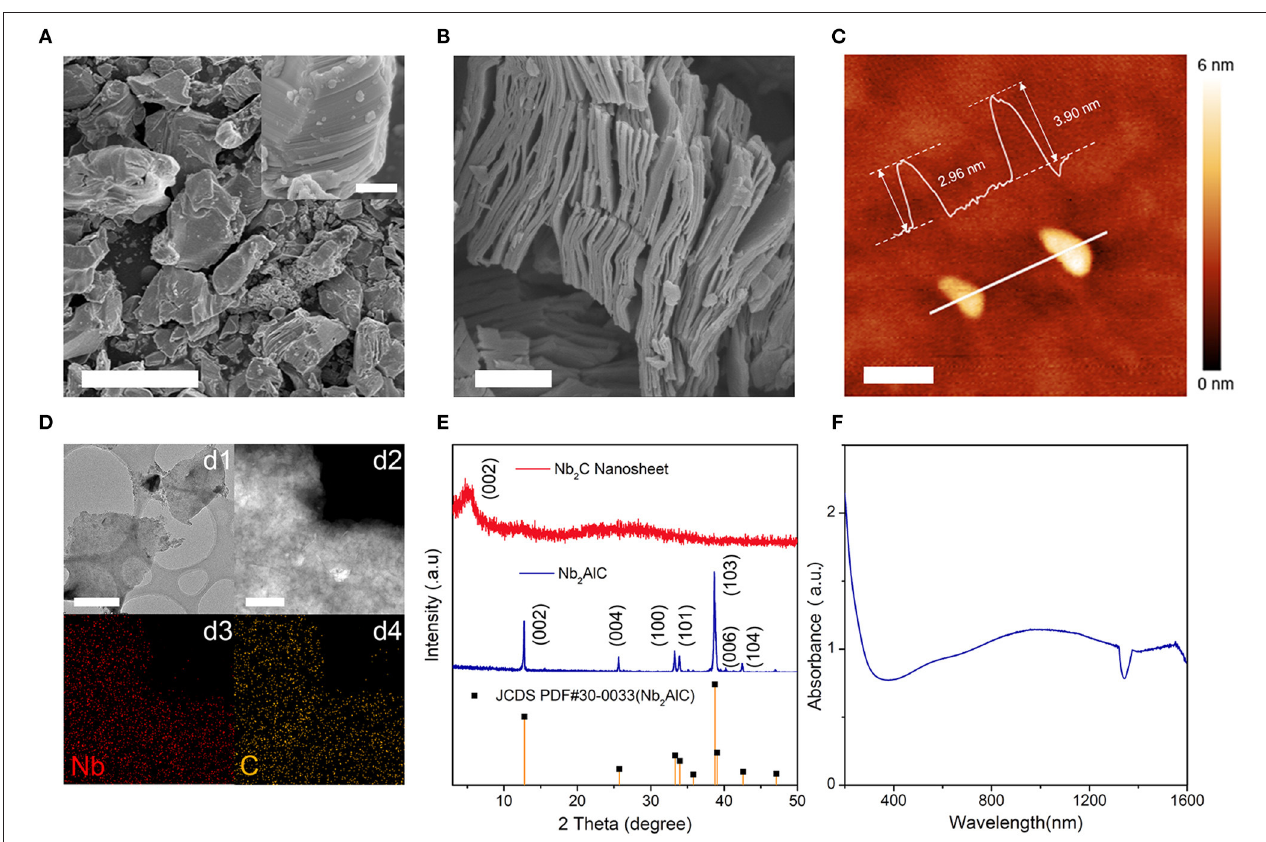
FIGURE 1 | (A) SEM images of Nb 2 AlC powder. Scale bars are 10 and 1 µ m in (A) and inset. (B) SEM image of multilayer Nb 2 C. Scale bar is 1 µ m. (C) AFM image of Nb 2 C. Scale bar is 200nm. ( D ,d1) TEM image, and (d2) HAADF image. (d3,d4) are EDS mapping of few-layer Nb 2 C nanosheets. Scale bars are 1 µ m and 200nm in (d1,d2). (E) XRD patterns of Nb 2 C (upper) and Nb 2 AlC (lower). (F) UV–vis–NIR absorption spectra of Nb 2 C.